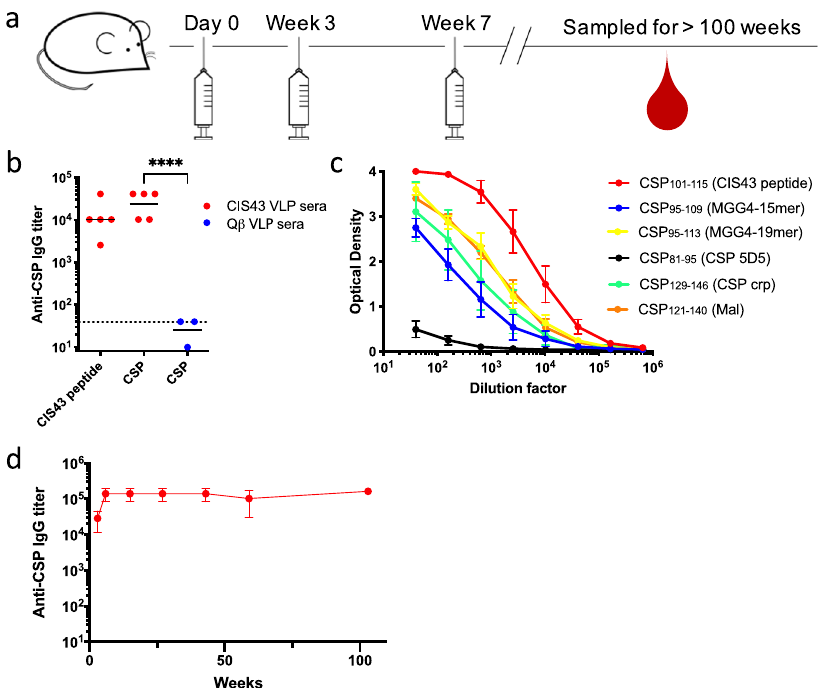
Fig. 2 CIS43 VLPs elicit high-titer and long-lasting antibody responses against CSP. a CIS43 VLP immunization scheme. b IgG titers against CIS43 peptide or CSP were assessed after two immunizations (6 weeks after the initial vaccination). Balb/c mice were immunized with 5 µg of CIS43 VLPs ( n = 5; red symbols) or 5 µg of WT Q β VLPs ( n = 3; blue symbols). Each data point represents an individual mouse and lines represent the geometric mean titers of each group. The dashed line indicates the limit of detection of the ELISA. Statistical signi fi cance between groups was determined by t -test (**** p < 0.0001). c Sera from CIS43 VLP-immunized Balb/c mice were tested for binding to different CSP peptides (listed in Supplementary Fig. 1) by ELISA. Data represents the mean values from fi ve mice immunized twice with unadjuvanted CIS43 VLPs. Error bars represent SEM. d Geometric mean IgG titers were determined longitudinally for over 100 weeks after the initial vaccination. It is noteworthy that three of the mice in the CIS43 VLP-vaccinated group were killed or died (at weeks 56, 60, and 60) due to health complications unrelated to vaccination and prior to the completion of the